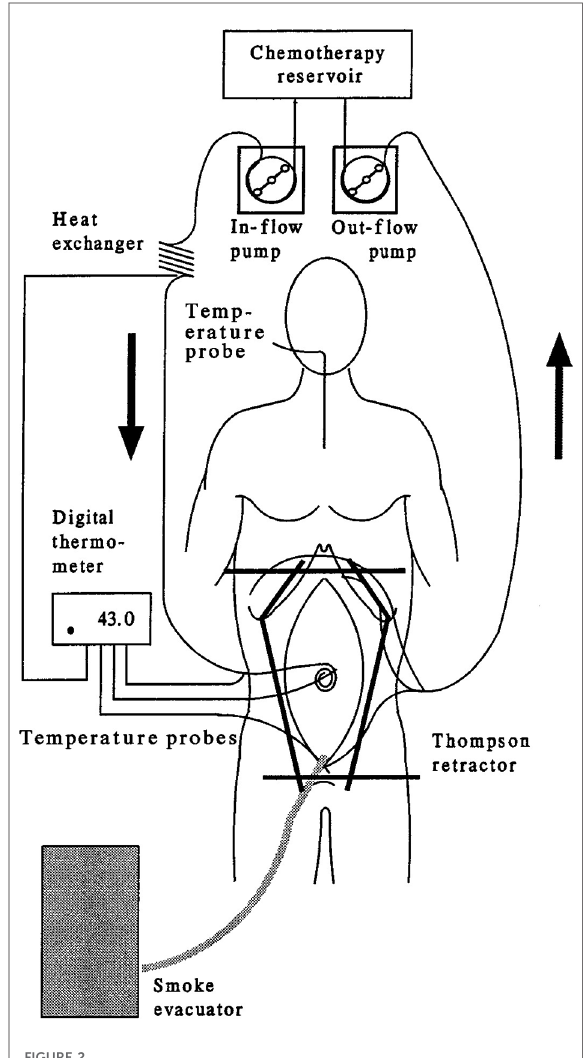
FIGURE 2 Equipment required for hyperthermic intraperitoneal chemotherapy (HIPEC)